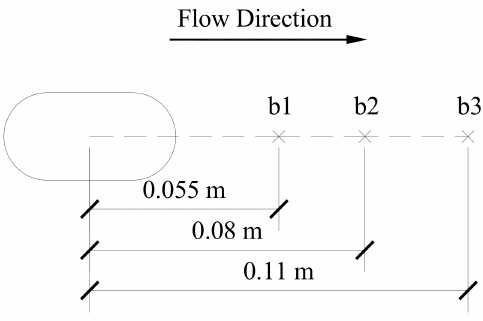
Figure 5. Schematic of ADV measuring point layout.